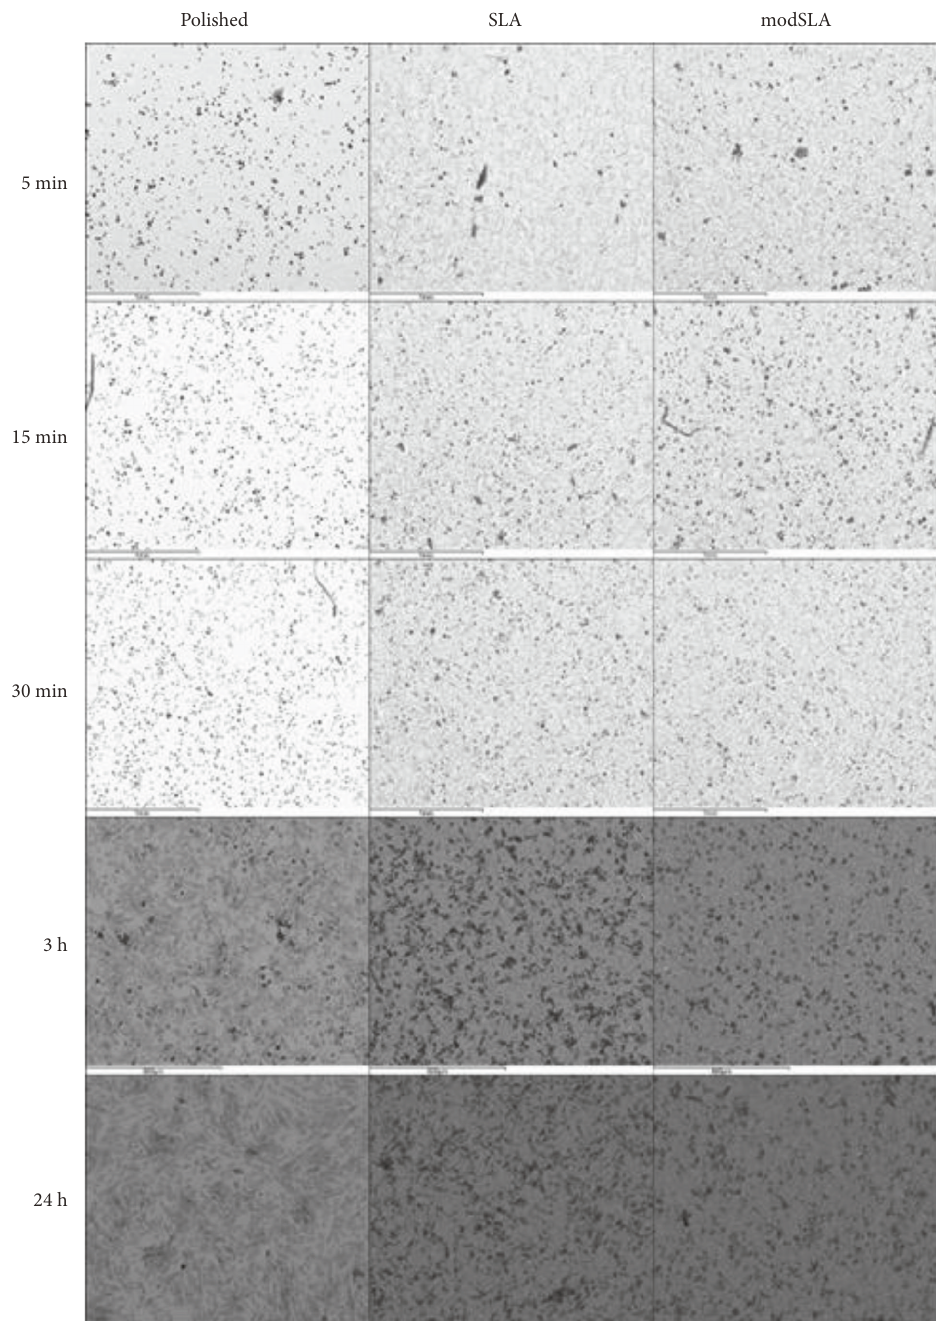
Figure 1: (a) Assessment of cell adhesion at 1, 3, and 24 h post contact demonstrated adherence at near-maximal numbers to each of the test surfaces by 1 h. Cell numbers increased slightly on tissue culture plastic but remained unchanged on the Ti surfaces. There was a signi fi cantly lesser number of cells on the rough compared to polished Ti surfaces. Shown are mean ± SD , N = donors = 2 , n = replicates = 3 . ∗ p < 0 05 , ∗∗ p < 0 01 , and ∗∗∗ p < 0 001 for tissue culture plastic compared to Ti surface. # p < 0 05 , ## p < 0 01 , and ### p < 0 001 , P compared to SLA or modSLA Ti surfaces. + p < 0 05 , ++ p < 0 01 , and +++ p < 0 001 , SLA compared to modSLA Ti surfaces. (b) Assessment of MSC adhesion within the fi rst hour of cell-substrate contact. The Calcein-AM cytoplasmic fl uorescence labelling indicated a higher number of cells adherent to the polished Ti compared with TCP and both modi fi ed rough Ti surfaces. Shown are mean ± SD , N = 3 , n = 3 . # p < 0 05 , ## p < 0 01 , and ### p < 0 001 for polished Ti compared to any surface. (c) Back-scattered scanning electron micrographs of Calcein- labelled samples from one MSC donor. Images of samples from the attachment assay con fi rmed the presence of a higher number of MSCs adherent to P compared to the modi fi ed rough Ti surfaces. Scale bar = 600 μ m